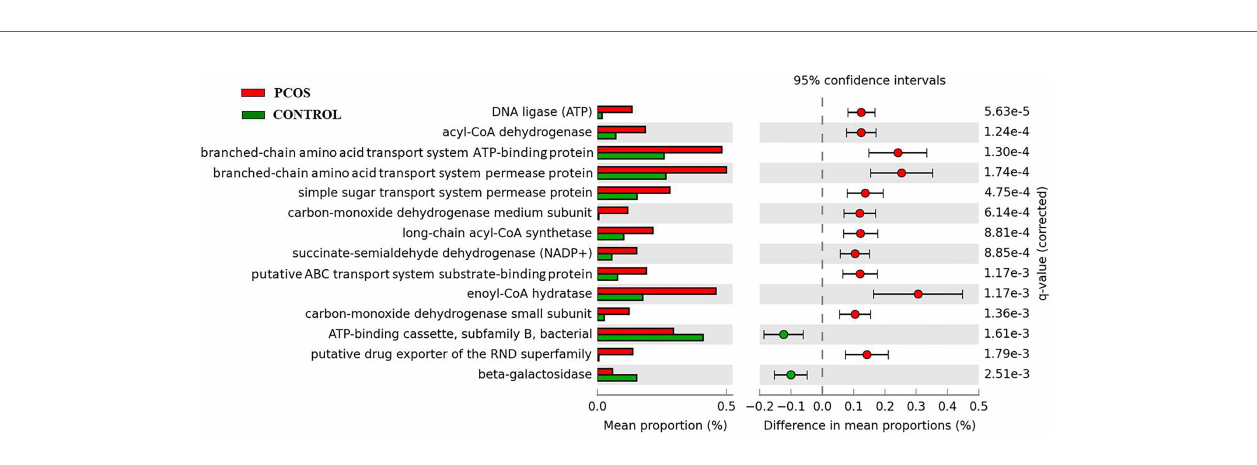
FIGURE 4 | KEGG pathways analysis of PCOS and control groups.